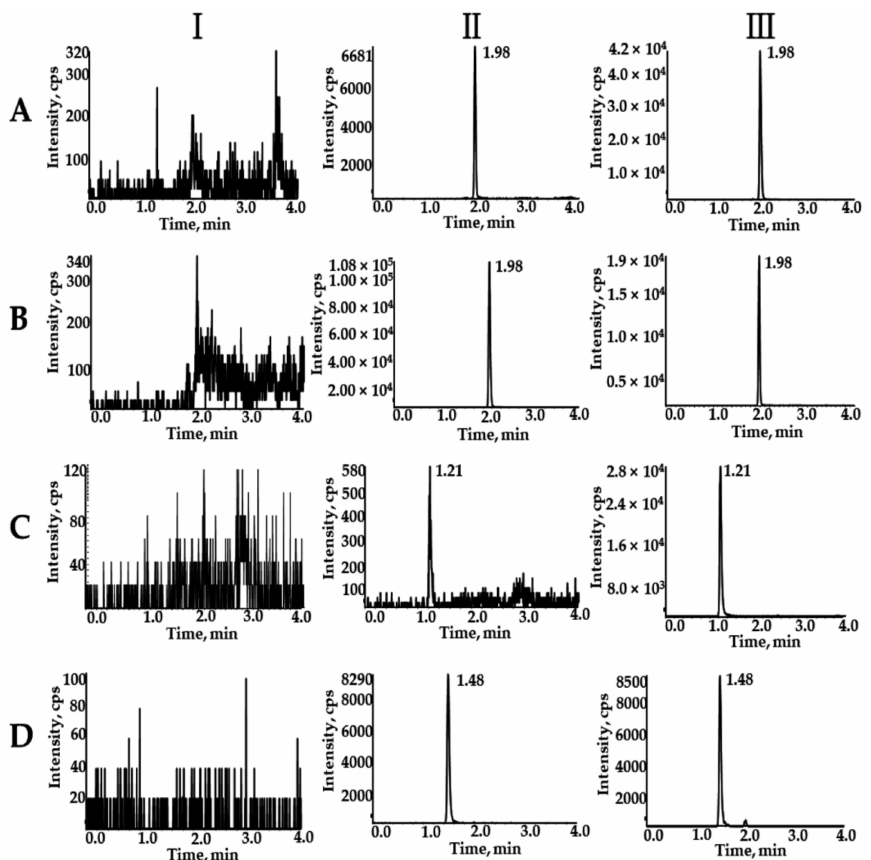
Figure 2. Typical chromatograms of SOR ( A ), SOR-d 3 ( B ), DAPA ( C ), and 2 H 4 -CAPA ( D ). I, blank plasma; II, blank rat plasma spiked with the mixed working solution at LLOQ level and IS; and III, rat samples after oral administration of SOR and DAPA.